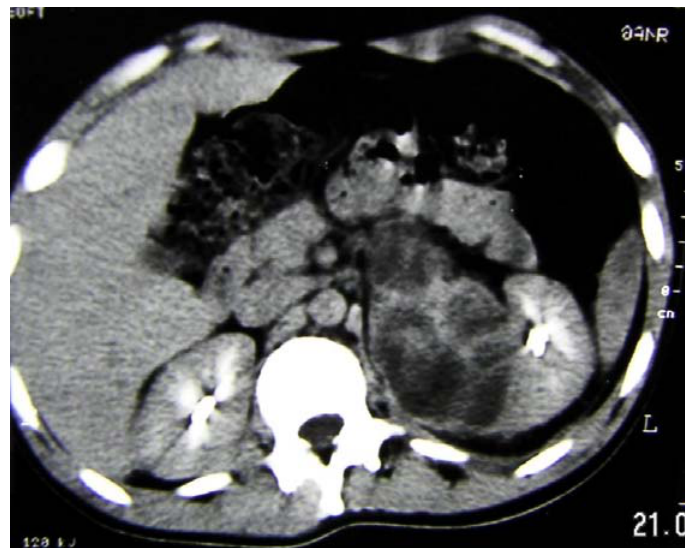
FIGURE 1. Preoperative CT scan